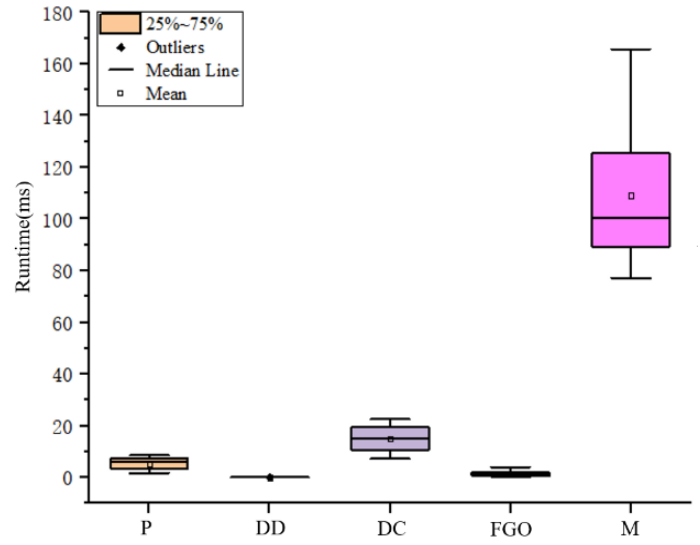
Figure 13. Time performance of the proposed